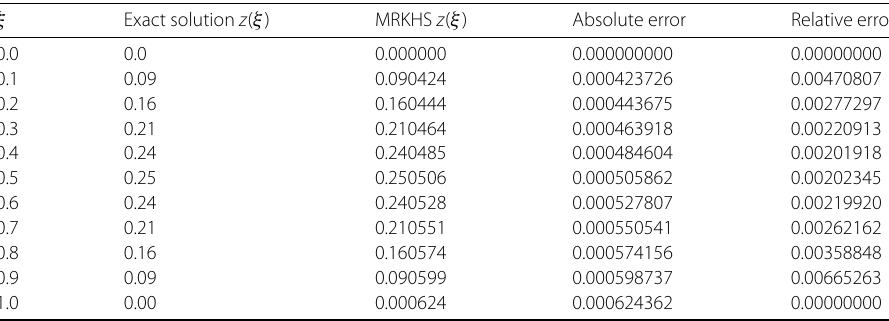
Table 1 Numerical results for Example 5.1 ξ Exact solution z ( ξ ) MRKHS z ( ξ ) Absolute error Relative error